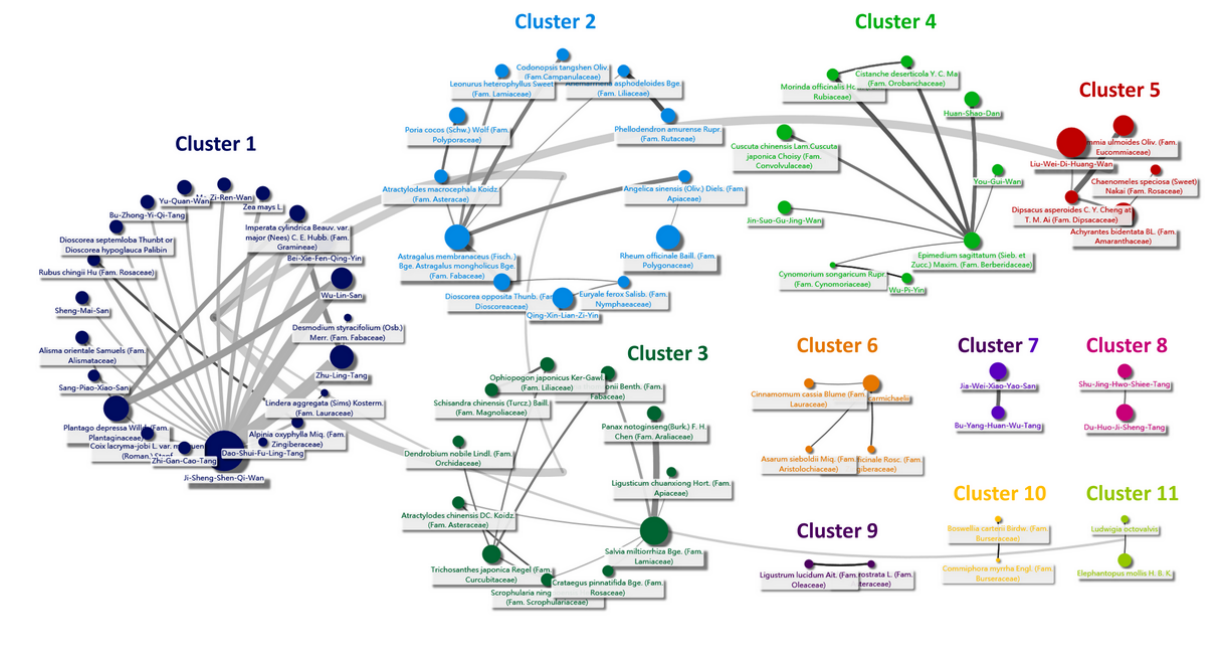
Figure 4. Chinese Herbal Medicine Network (CMN) for diabetic kidney disease. Relations are indicated by grey lines connected to the center of